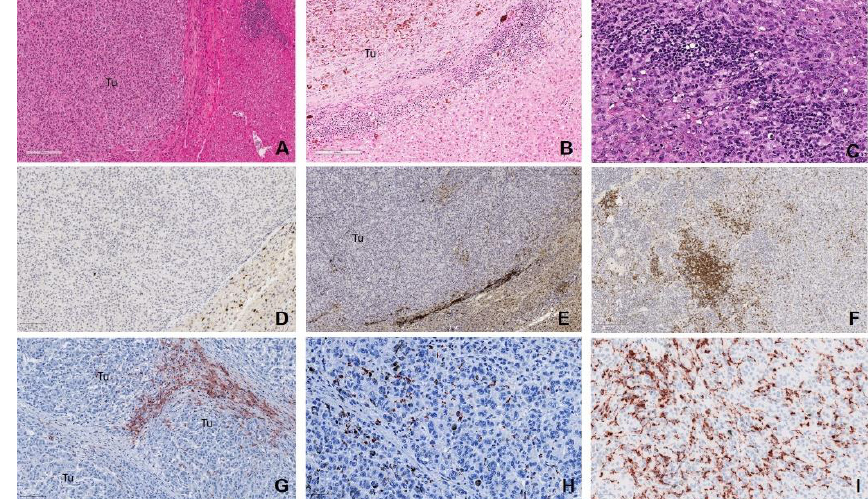
Figure 6. Grading of tumour immunoscore. H&E photomicrographs demonstrating: ( A ) “absent/cold” tumour with no TILs or TAMs within the tumour (Tu) or at the tumour-normal liver interface, given a “low” immunoscore (scale bar: 200 µm). The “intermediate/altered” categories: ( B ) “altered excluded,” where TILs or TAMs infiltrates were low at the tumour centre (Tu) and high at the margin (scale bar: 200 µm); “altered immunosuppressive,” a low scattered pattern of TILS/TAMS (not shown here). ( C ) “High/hot,” with marked TILs or TAMs infiltration throughout the metastatic deposit (scale bar: 50 µm). ( D – F ) CD8+ TILs for each of the categories, respectively (scale bar: 100 and 200 µm, respectively). CD163+ TAMs for the categories: ( G ) “altered excluded,” (scale bar: 100 µm) ( H) “altered immunosuppressed” and I) “high” (scale bar: 50 µm).